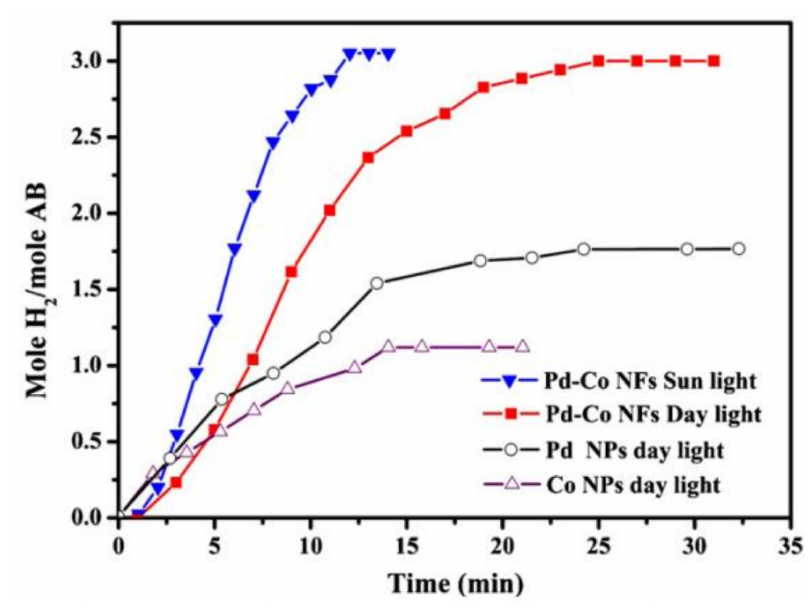
Figure 26. Catalytic performance of Pd, Co, and Pd-Co NFs in AB reaction. Reprinted from refer- ence [10] with permission from